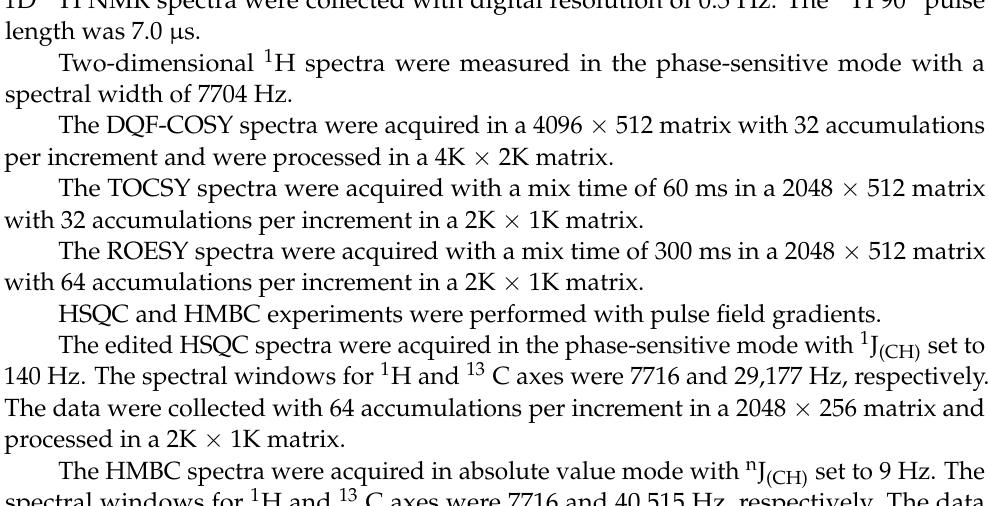
A. Figure S4: The DQF-COSY spectrum of iso-partricin B. Figure S5: The TOCSY spectrum of iso- partricin A. Figure S6: The TOCSY spectrum of iso-partricin B. Figure S7: The ROESY spectrum of iso-partricin A. Figure S8: The ROESY spectrum of iso-partricin B. Figure S9: Edited 1 H- 13 C HSQC spectrum of iso-partricin A. Figure S10: The 1 H- 13 C HMBC spectrum of iso-partricin A. Figure S11: Edited 1 H- 13 C HSQC spectrum of iso-partricin B. Figure S12: The 1 H- 13 C HMBC spectrum of iso-partricin B, Figure S13: HPLC-DAD-ESIMS chromatogram of isolated iso-partricin A. Figure S14: HPLC-DAD-ESIMS chromatogram of isolated iso-partricin